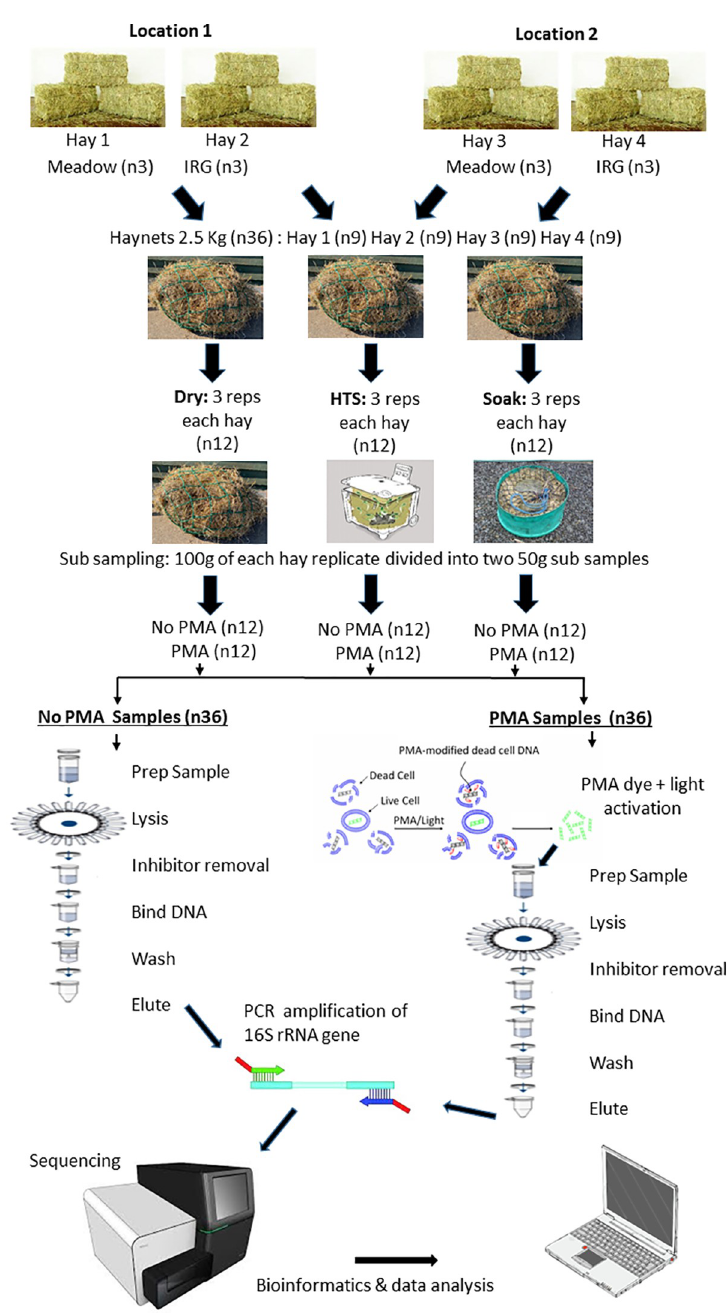
Fig 1. Flow diagram of the sampling method. Flow diagram of the experimental method, PMA adapted from PromoKine, DNA extraction adapted from Qiagen.